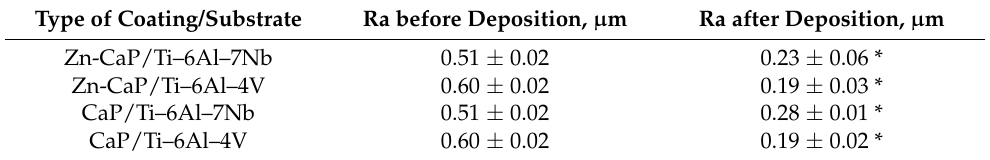
Figure 2. Surface morphology of ( a ) CaP and ( b ) Zn-CaP coating deposited on Ti–6Al7–Nb, and surface morphology of ( c ) CaP and ( d ) Zn-CaP coating deposited on Ti–6Al–4V. Table 2. Results of surface roughness determination before and after CaP coating deposition, X ± S.E.M. Type of Coating/Substrate